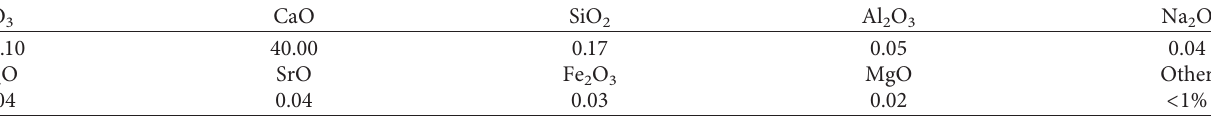
Table 2: The chemical composition of ultrahigh-strength gypsum (mass fraction)